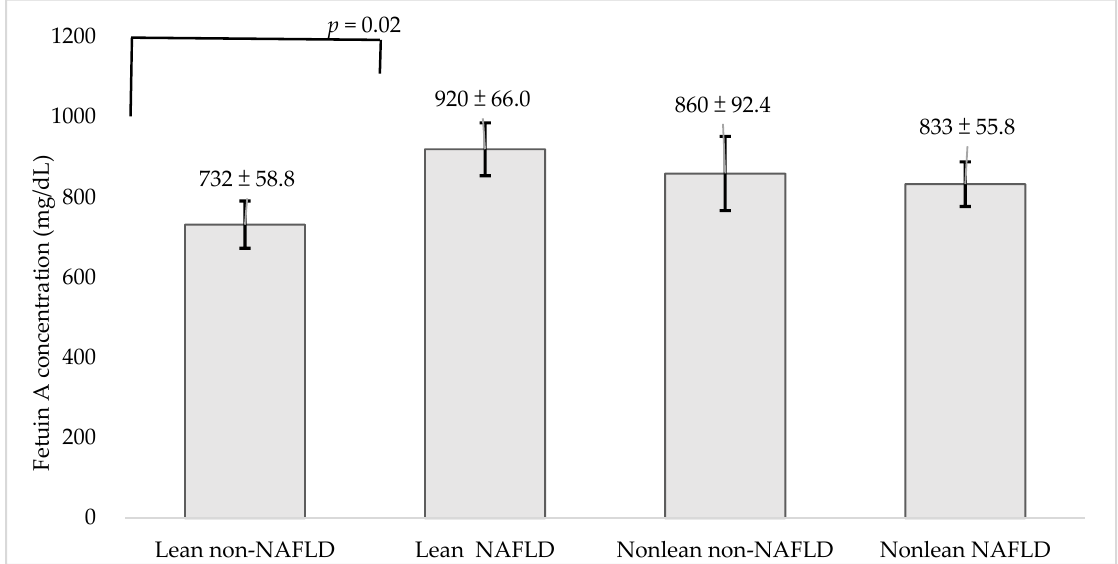
Figure 1. Comparison of serum concentrations of fetuin-A in relation to the groups of NAFLD after adjusting age, gender,